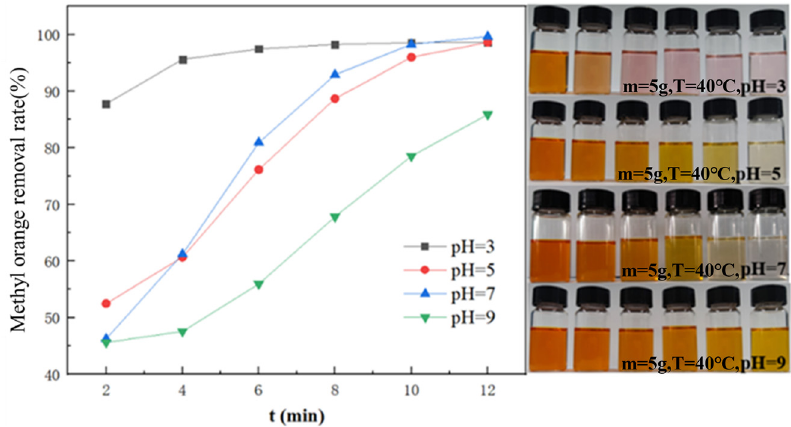
Figure 16. E ff ect of initial pH on the removal of methyl orange. Figure 16. Effect of initial pH on the removal of methyl